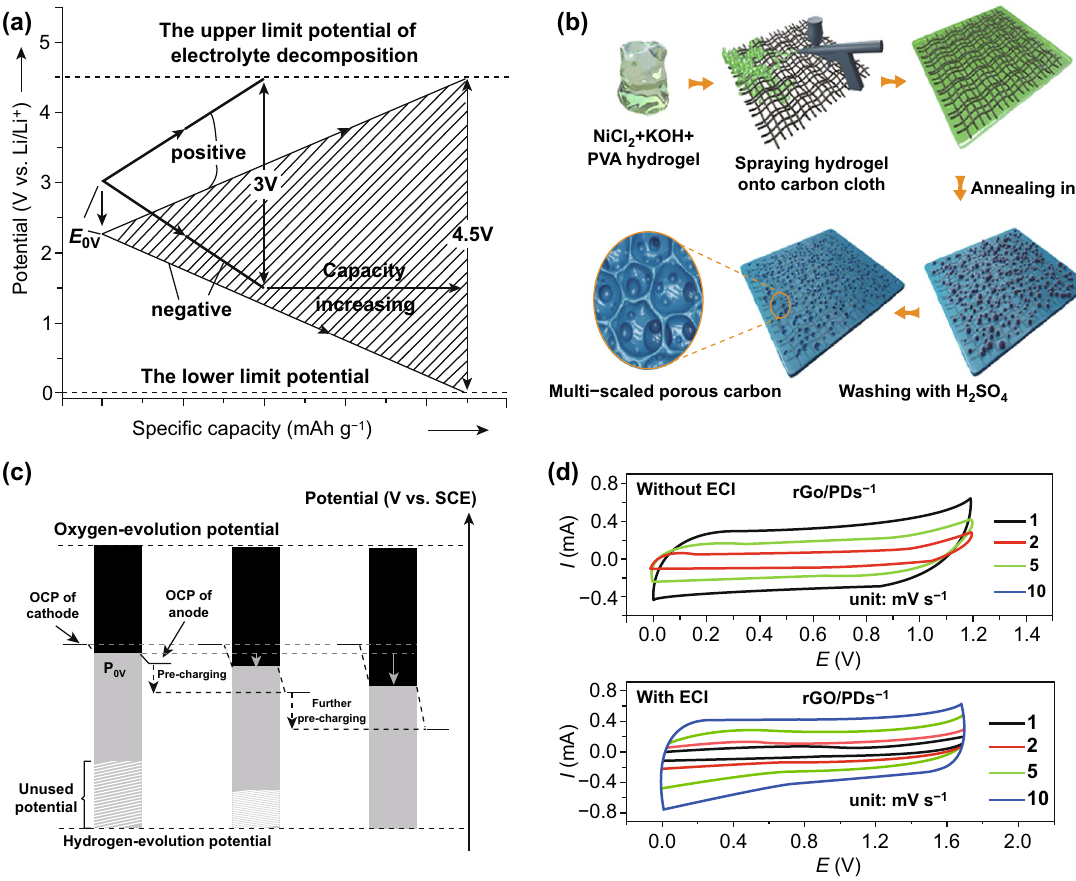
Fig. 4 a Mechanism illustration of optimizing the surface charge density to extend the electrode potential window. The shadowed area is equal to the value of the energy density. Adapted with permission from Ref. [51]. The illustration of b the synthesis procedure of MSPC on car‑ bon cloth and c tuning the electrode potential range downward through pre‑charging treatment. Adapted with permission from Ref. [59]. d CV curves of rGO/PDs‑1‑based FSC without (above) and with ECI (below). Adapted with permission from Ref.